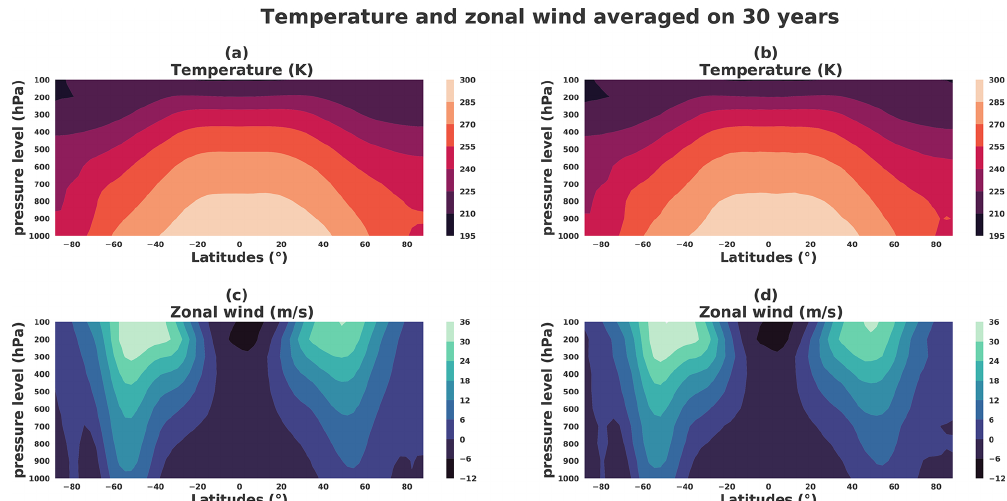
Figure 23. Temperature (K) and zonal wind (ms − 1 ) latitude zonals averaged on the 30-year subsample. Left panels correspond to a situation taken from the dataset: (a) zonal temperature and (c) zonal wind. Right panels correspond to a situation taken from the generator: (b) zonal temperature and (d) zonal wind.